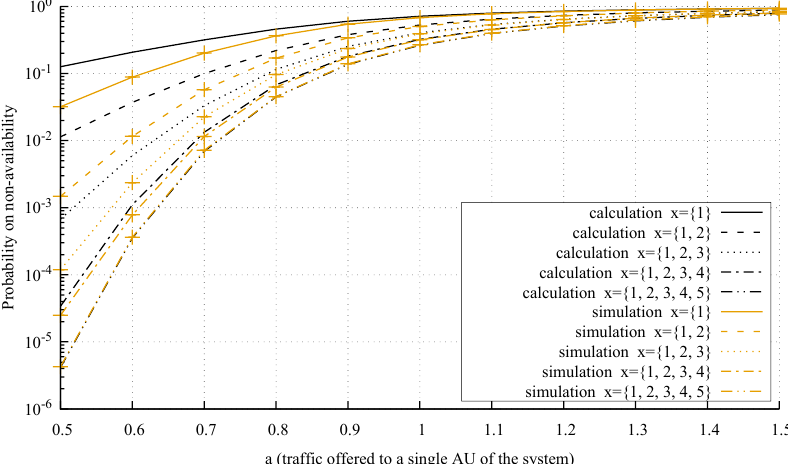
Figure 8. Probability of the non-availability of x strictly determined resources for class 2 calls ( t 2 = 3) in System 3, where x is the set of strictly determined resources in the limited-availability group.